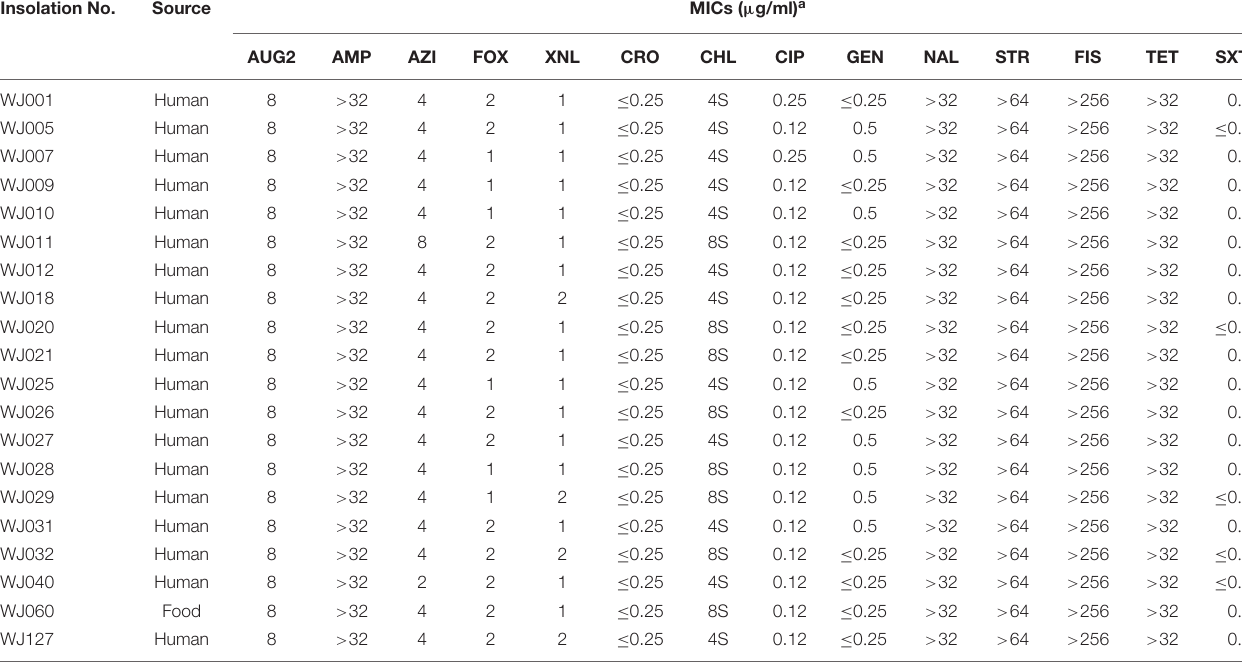
TABLE 2 | Resistance results of 14 antibiotics for 20 outbreak S . enteritidis strains. Insolation